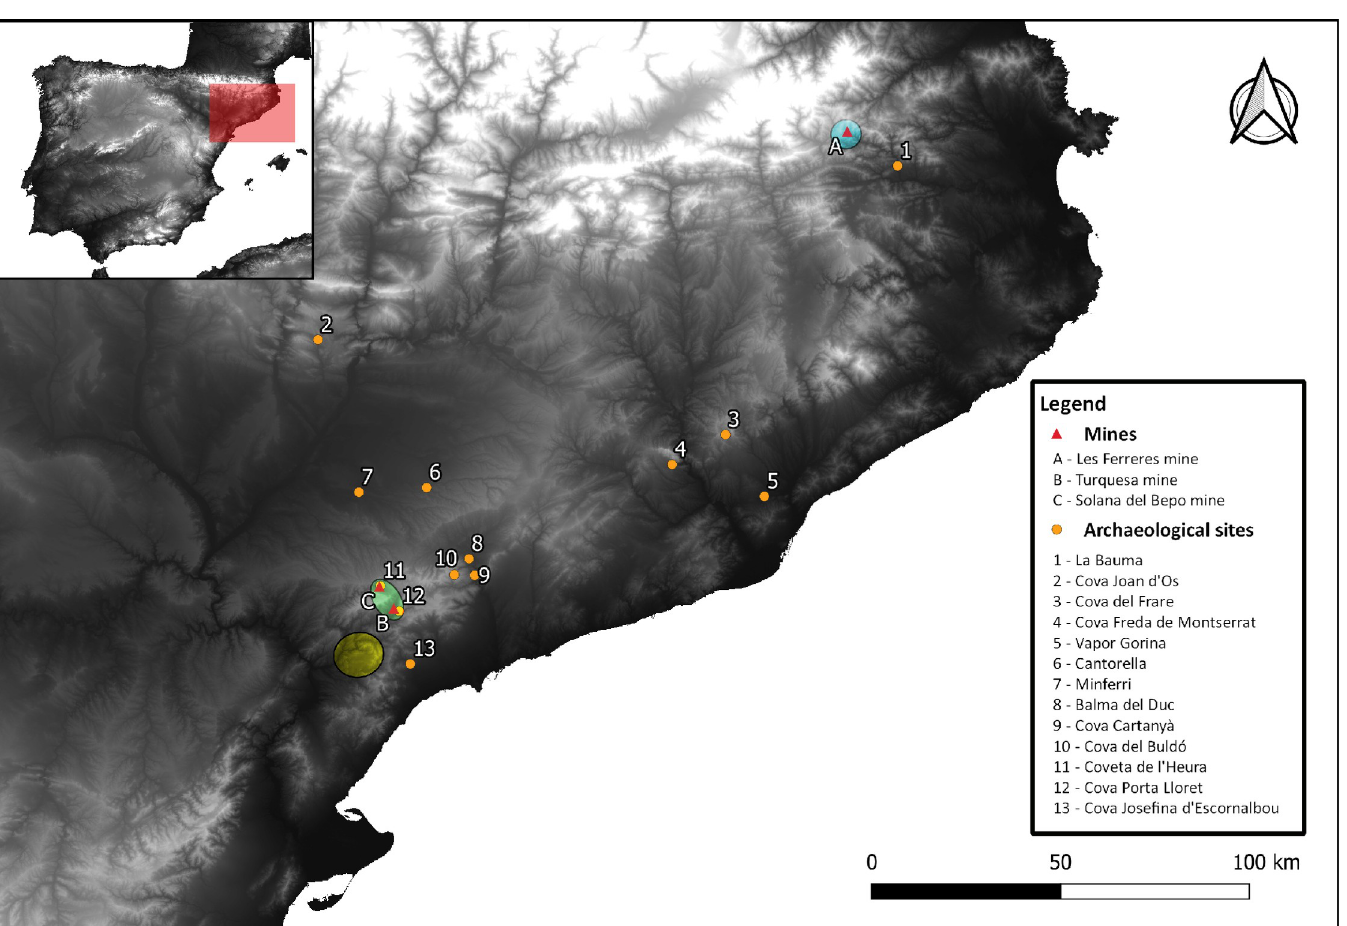
Fig 1. Map of the Northeast with key sites mentioned in this paper. (Green circle) Montsant mining district. (Yellow circle) MBF mining district. (Blue circle) Les Ferreres mining district. (Raster model: STRM DEM from NASA).